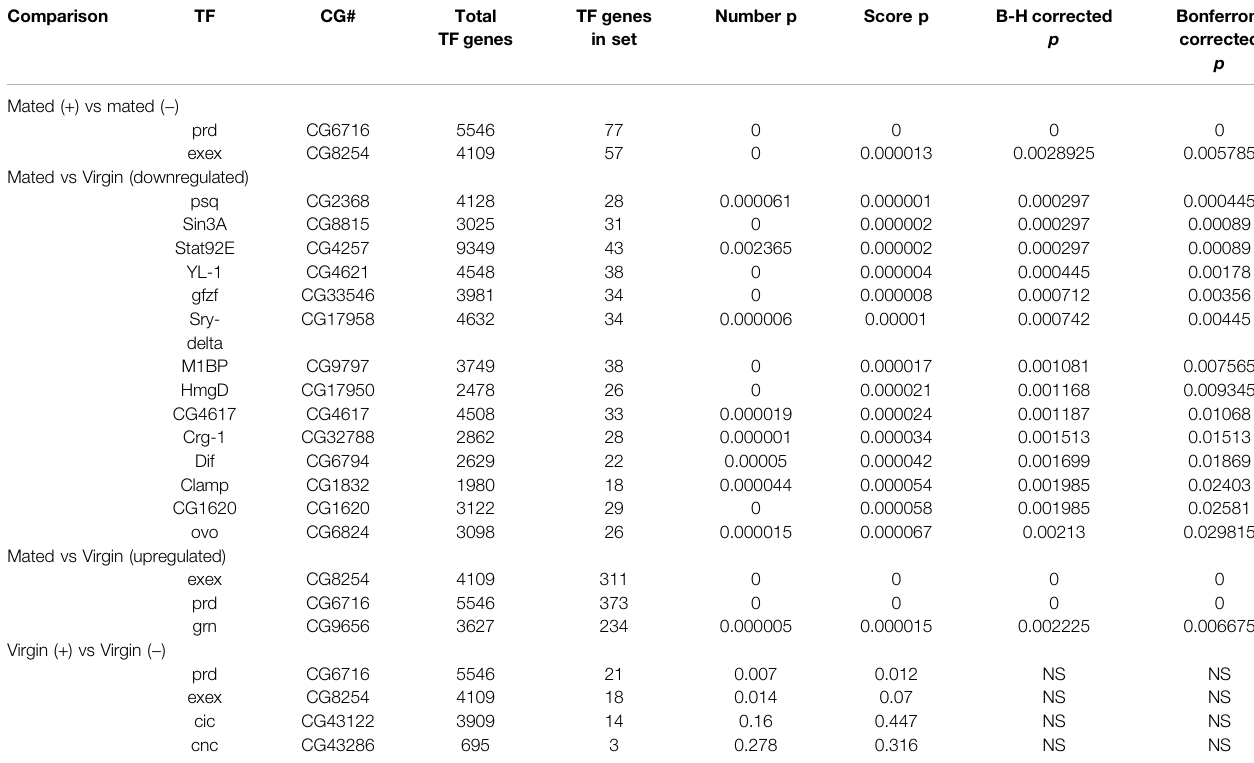
TABLE 2 | Transcription factor binding site enrichment in genes regulated by mating and by mifepristone.